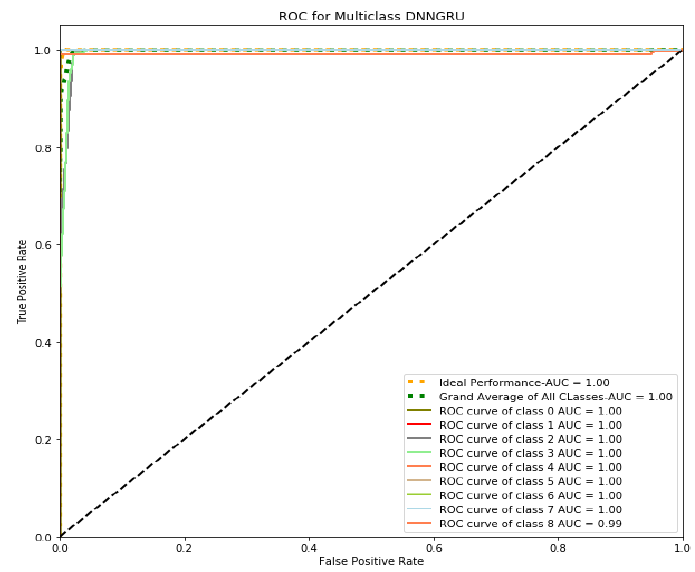
Figure 8. ROC curve analysis.